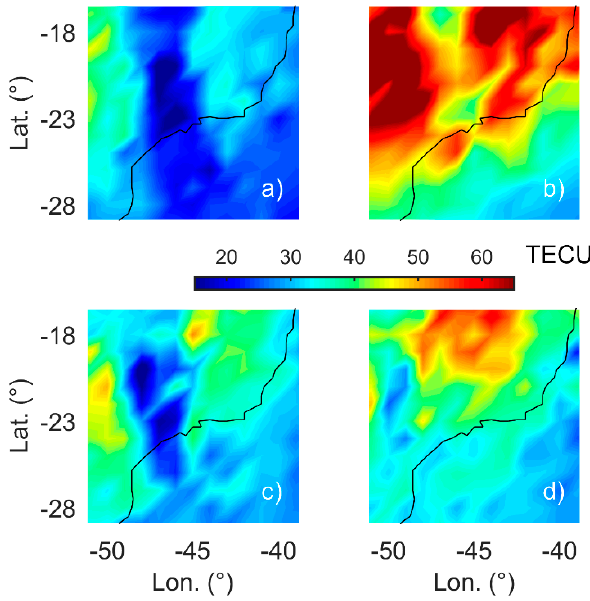
Figure 6. Four cases to build the confusion matrix using the VTEC reconstructions in CHPI.